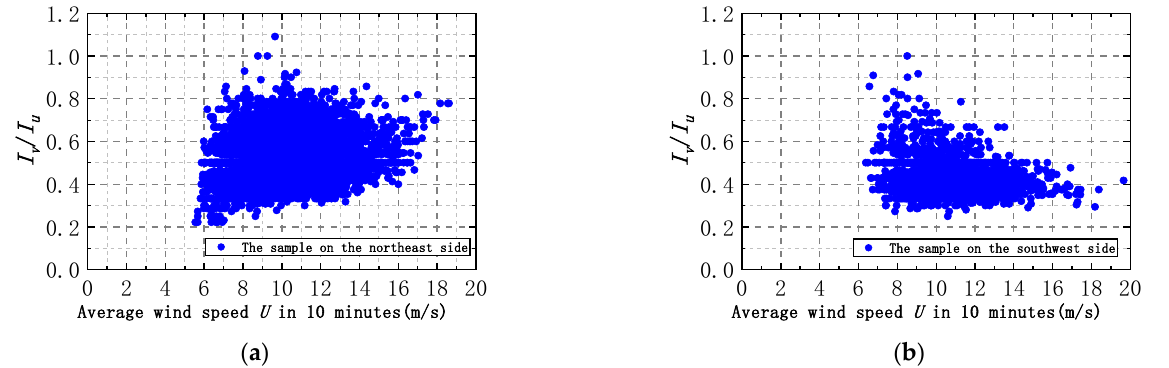
Figure 17. The correlation between the turbulence ratio I v / I u and the mean wind speed U : ( a ) the northeast side; ( b ) the southwest side. Table 2. Distribution interval and expected value of the turbulence ratio corresponding to different wind speed ranges. Wind Speed Range (m/s)